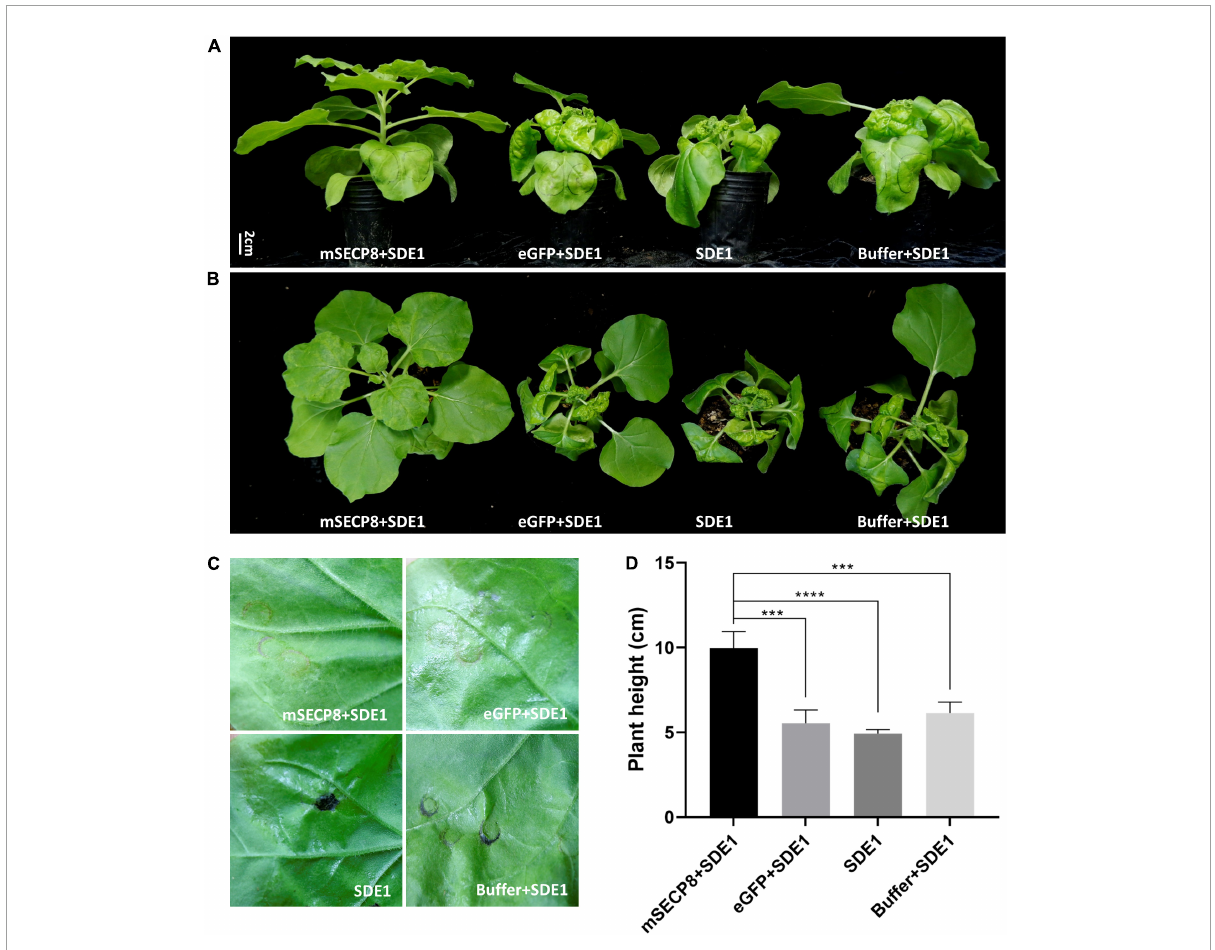
FIGURE3 mSECP8 inhibited water-soaked necrosis and dwarfing phenotype induced by SDE1. Nicotiana benthamiana leaves were infiltrated with A. tumefaciens harboring mSECP8 , eGFP or with buffer followed 24 h later by Agrobacterium tumefaciens carrying SDE1 . (A,B) Photos were taken at 15 days for plant phenotypes and (C) 4 days for inoculated-leaves in N. benthamiana , respectively. (D) The height of N. benthamiana -inoculated plants at 15 dpi. The asterisks indicate significant difference (*** p < 0.001, **** p < 0.0001, determined by one-way ANOVA with Dunnett’s test). Scale bar represents 2 cm in (A) . The experiment contains at least three independent biological